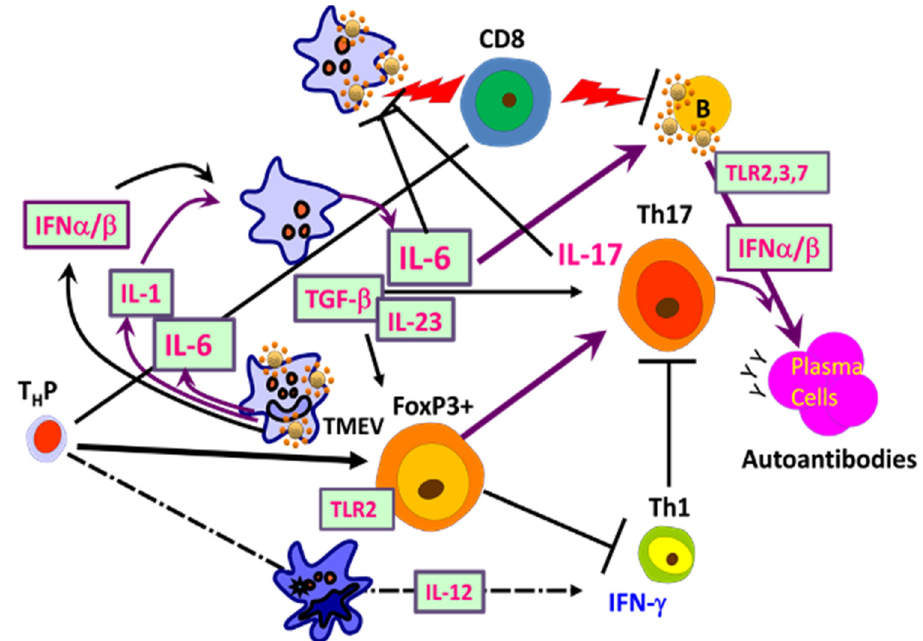
Figure 5. Interactions of adaptive immune responses to TMEV and autoantigens in susceptible mice.